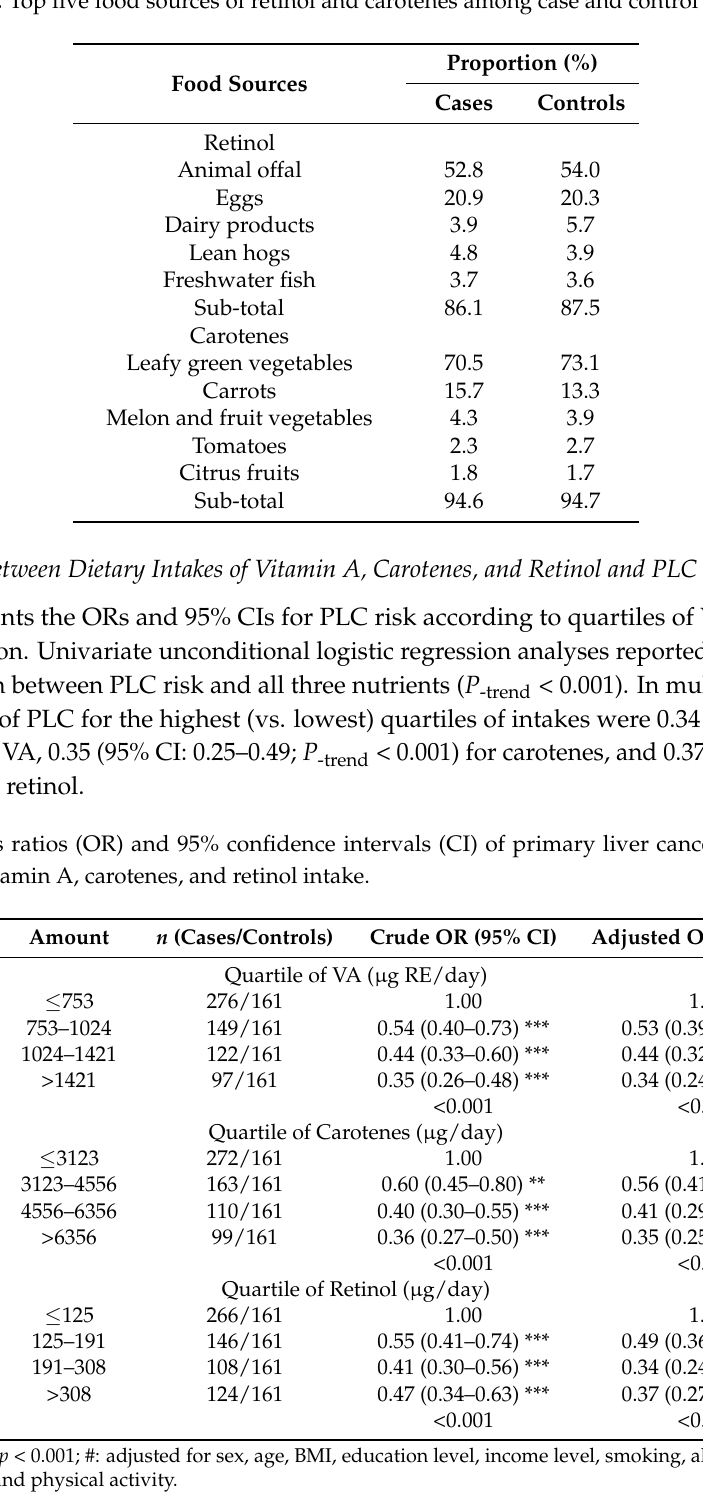
Table 2. Top five food sources of retinol and carotenes among case and control subjects.